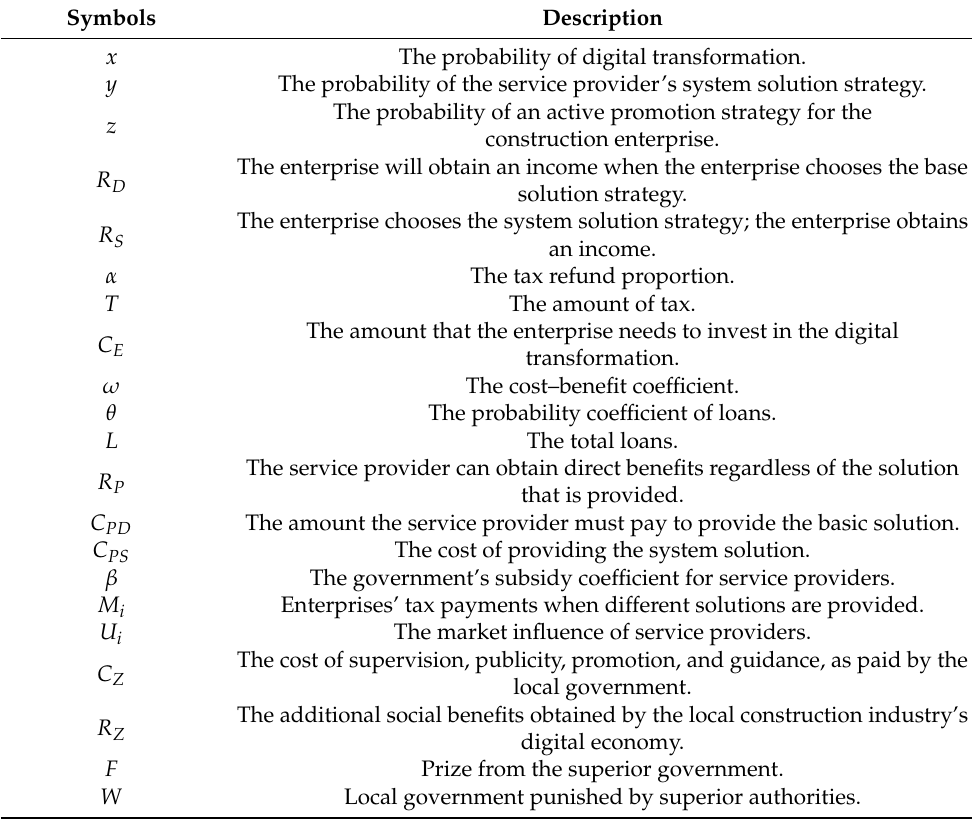
Table 1. The meaning of the variables and parameters in the perceived payoff matrix. Symbols